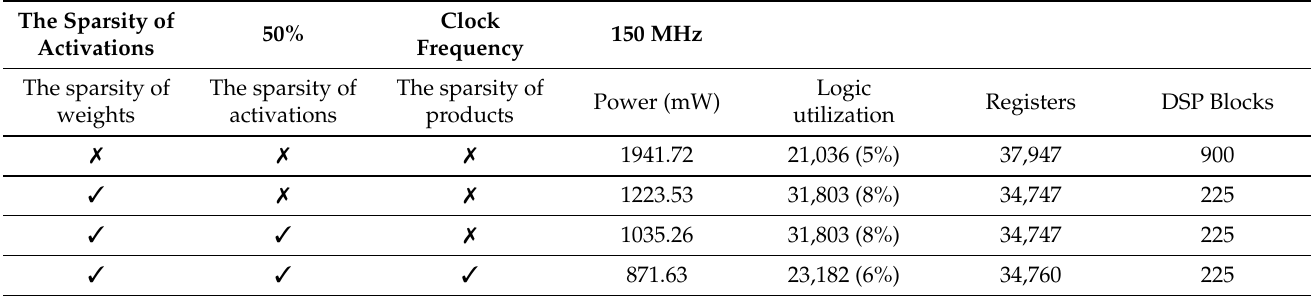
Table 4. The breakdown of both energy and resources saved by utilizing three types of sparsity.